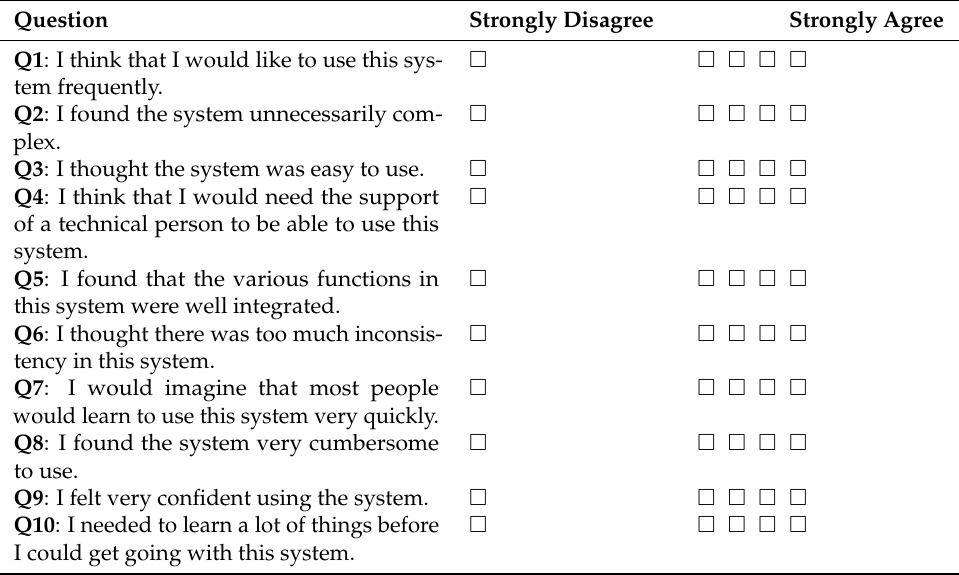
Table A1. System Usability Scale